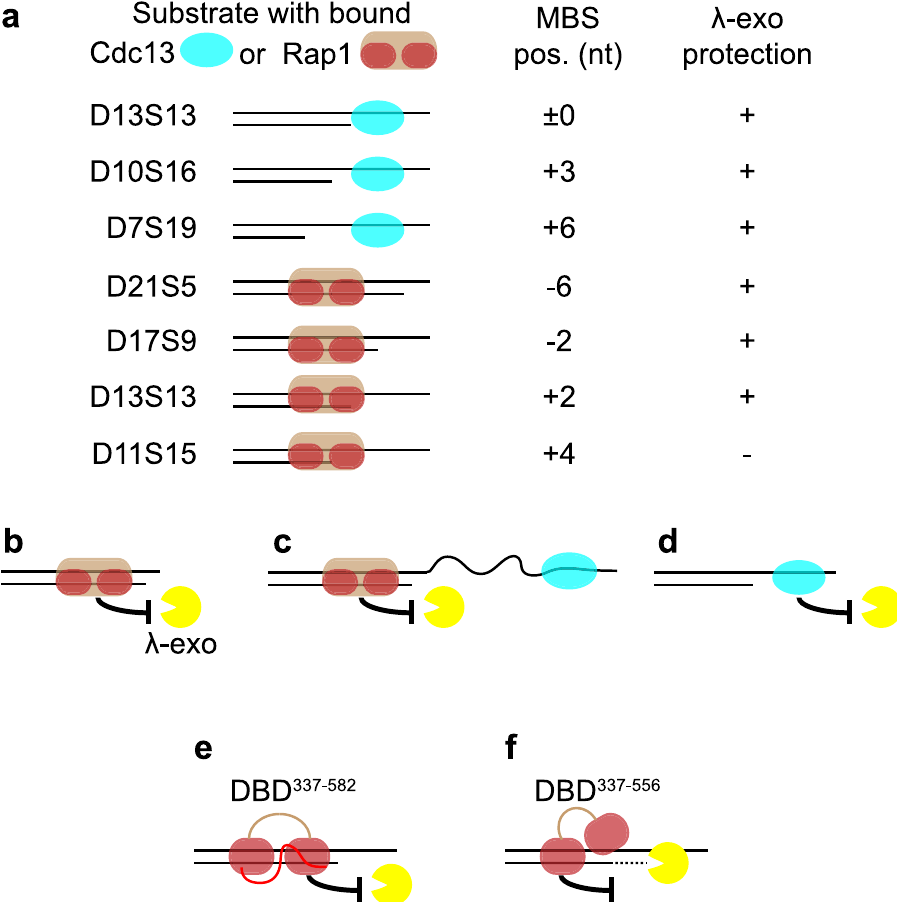
Figure 9. Schematic figure summarizing the results of this work and how it is proposed to relate to different in vivo situations. ( a ) Shows the different substrate tested with Cdc13 or Rap1 pre-bound at their respective MBS at various distances relative the ds-ss junction. “ + ” indicates protection, while “ − ’’ indicates no protection. ( b ) Protection by Rap1 when the 3 ′ overhang is very short and unable to accommodate Cdc13 binding. ( c ) Protection by Rap1 in a hypothetical situation where Cdc13 is bound very far away from the ds-ss junction (longer than tested here). ( d ) Protection may be provided by Cdc13 alone when the 3 ′ overhang accommodates its binding. ( e ) The wild type Rap1 DBD 337–582 is firmly attached to its MBS, and fully protects the 5 ′ end from degradation by λ -exonuclease. ( f ) The Rap1 wrapping loop mutant DBD 337–556 is only partly attached to the MBS, leaving the 5 ′ end accessible to λ -exonuclease, which cleaves off the first 3 nt of DNA before being halted at a site where the mutant DBD is more firmly